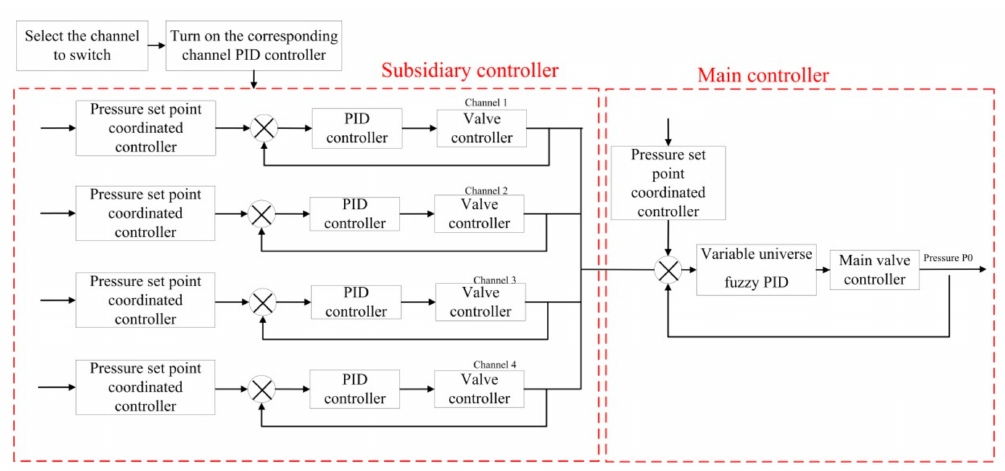
Figure 9. The MCCS system control structure diagram.